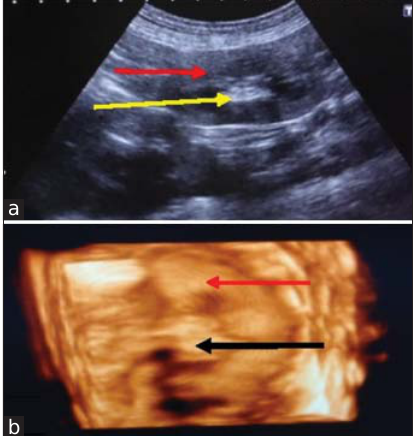
Figure-1: Nephritis (Case 1): (a) In two-dimensional ultrasonogram of kidney, the echogenicity of renal parenchyma has increased without differentiation of cortex and medulla (red arrow). Echogenic renal crest (yellow arrow), (b) in three-dimensional (3D) renal parenchyma without distinction of cortex and medulla (red arrow). Renal crest visible in the center (black arrow).